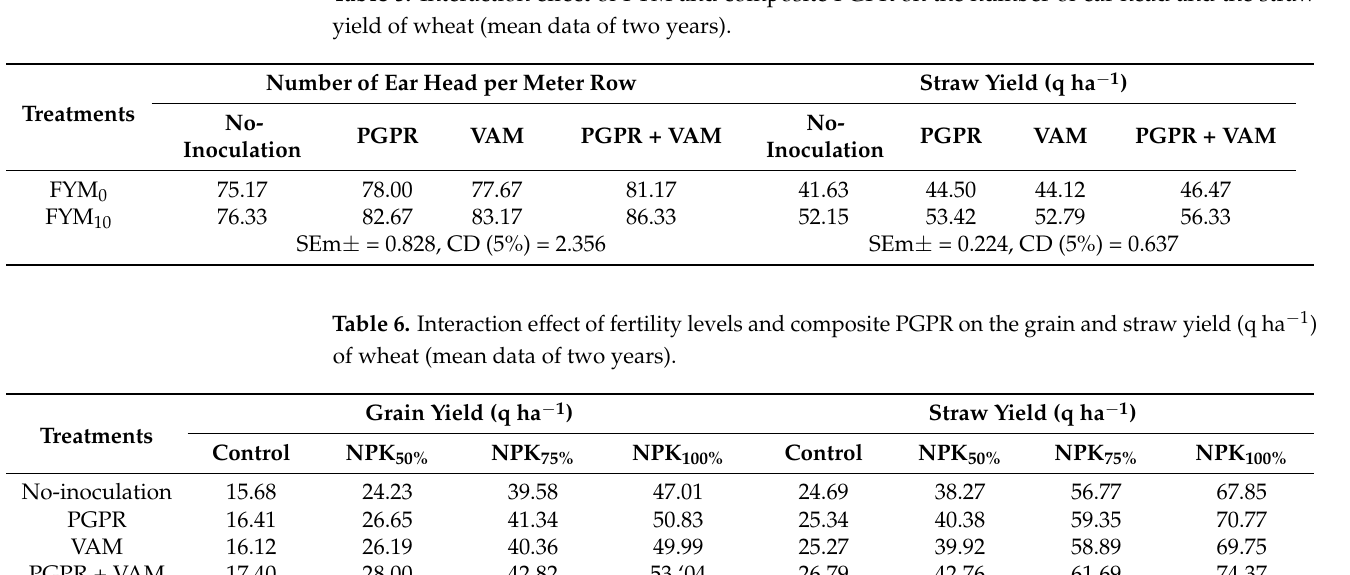
Table 8. Interaction effect of fertility levels, FYM, and bio-inoculants on the economics (B:C ratio) of wheat (mean of two years).